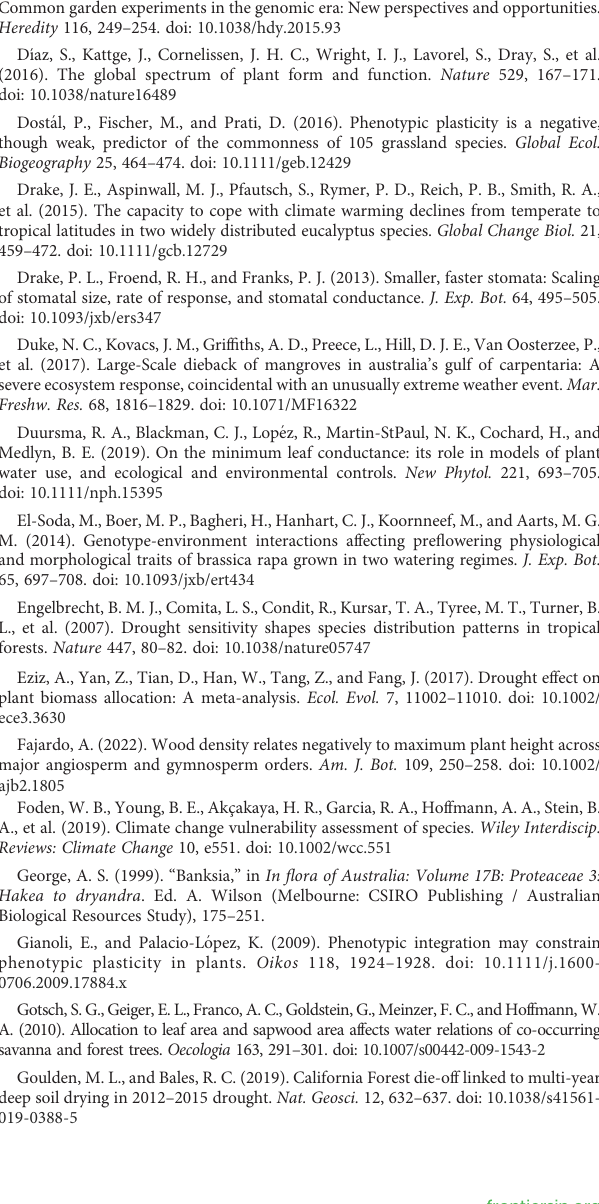
populations under water-limited (WL) and well-watered (WL)